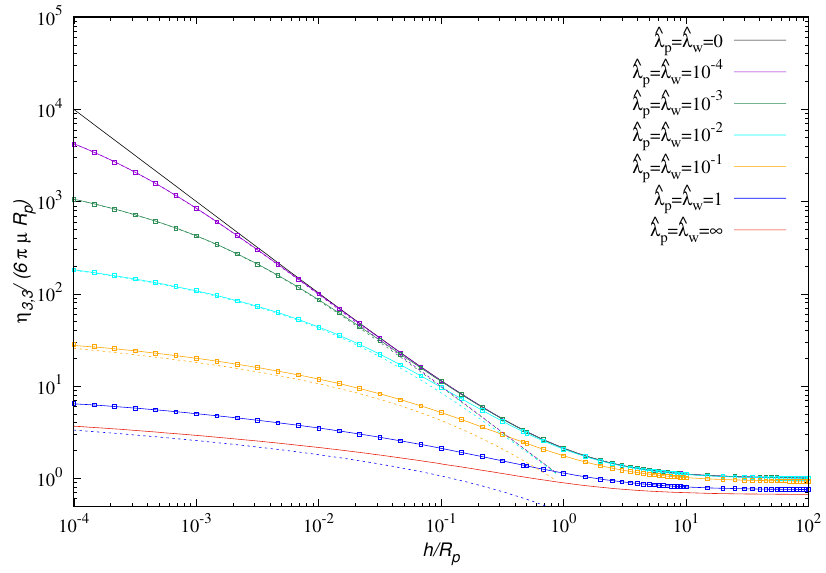
Figure 2. Dimensionless hydrodynamics resistance coefficient η 3,3 / ( 6 π µ R p ) vs h / R p for equal slip lengths on the particle surface and on the wall. Each color in the figure corresponds to a different slip length as described in the inner legend. Continuous lines represent the results of the Goren’s equations, dotted lines the values obtained by the Hocking’s equation Equation (104), and symbols the results of FEM